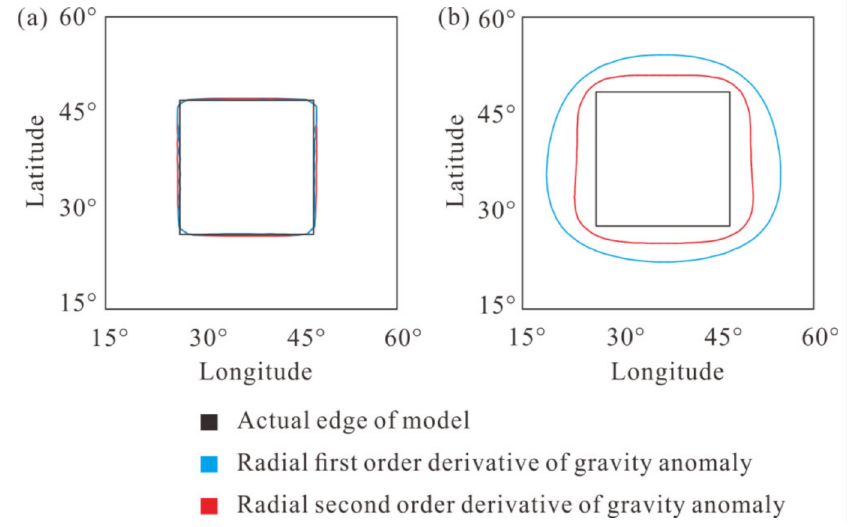
Figure A7. ( a ) Zero value lines of different radial derivatives of gravity at r 0 = 5000 km; ( b ) Zero value lines of different radial derivatives of gravity at r 0 = 6000